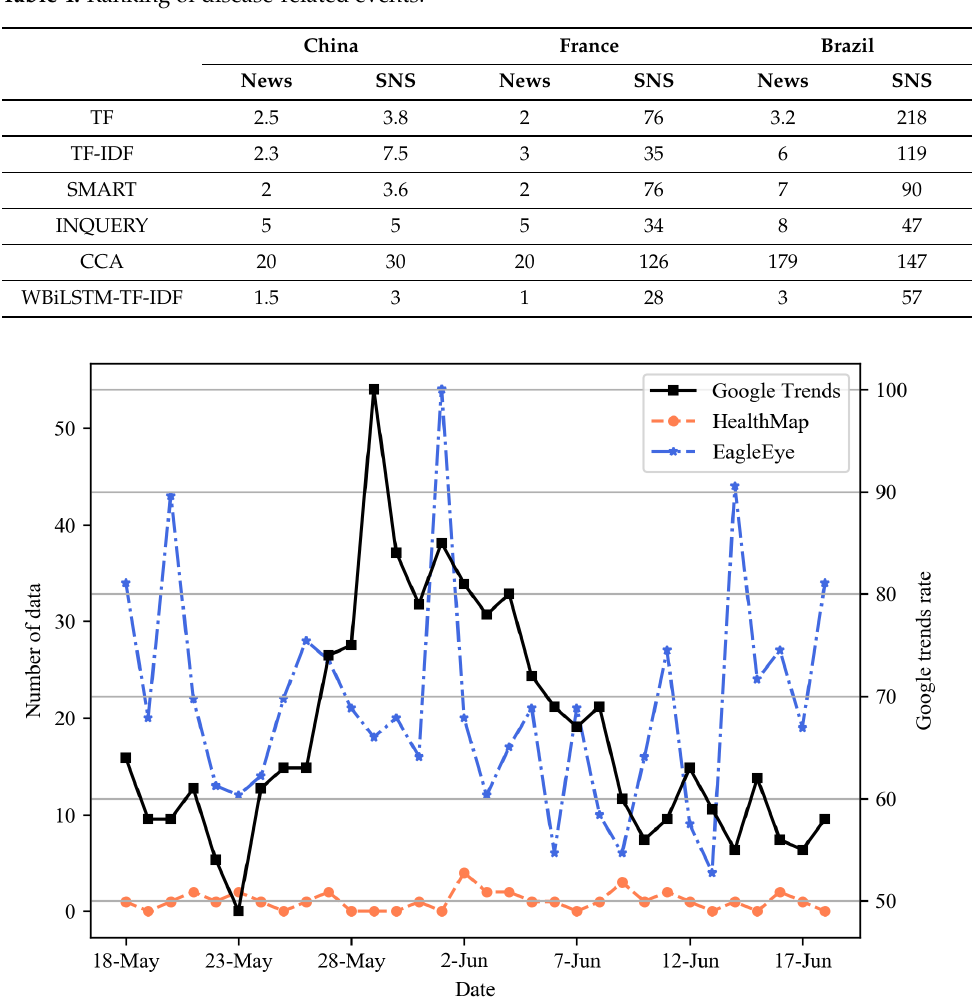
Figure 8. Daily time-series number of COVID-19-related data for